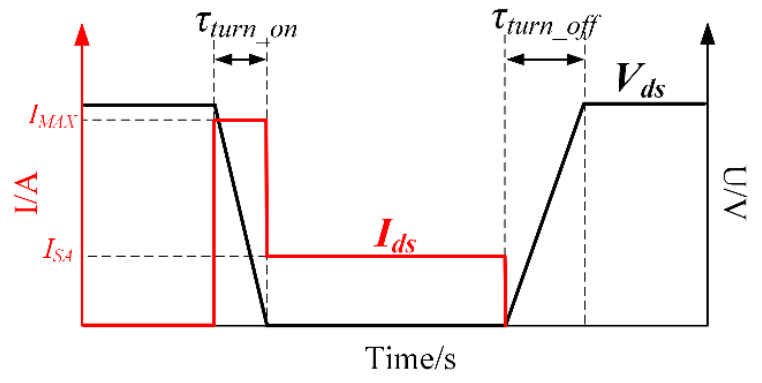
Figure 8. Switching mode of MOSFET.